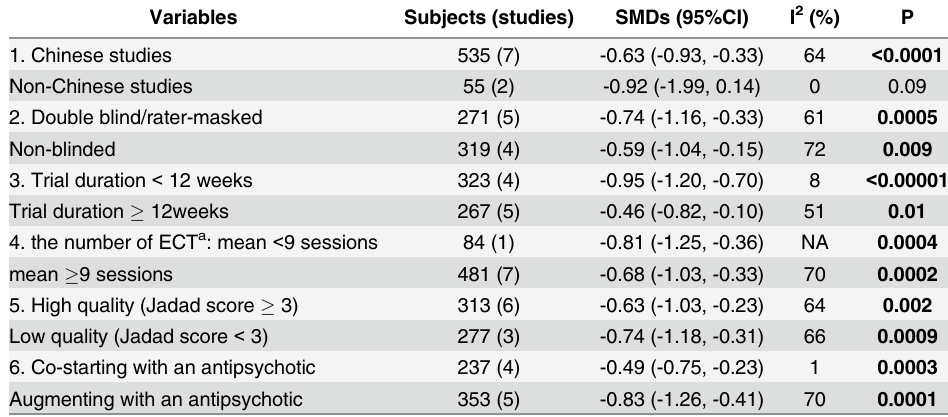
Table 2. Subgroup and sensitivity analysis of the effect of mediator variables on the outcome of “ end- point symptomatic improvement ” .